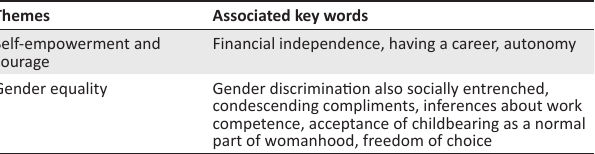
TABLE 2: Factors unique to the women